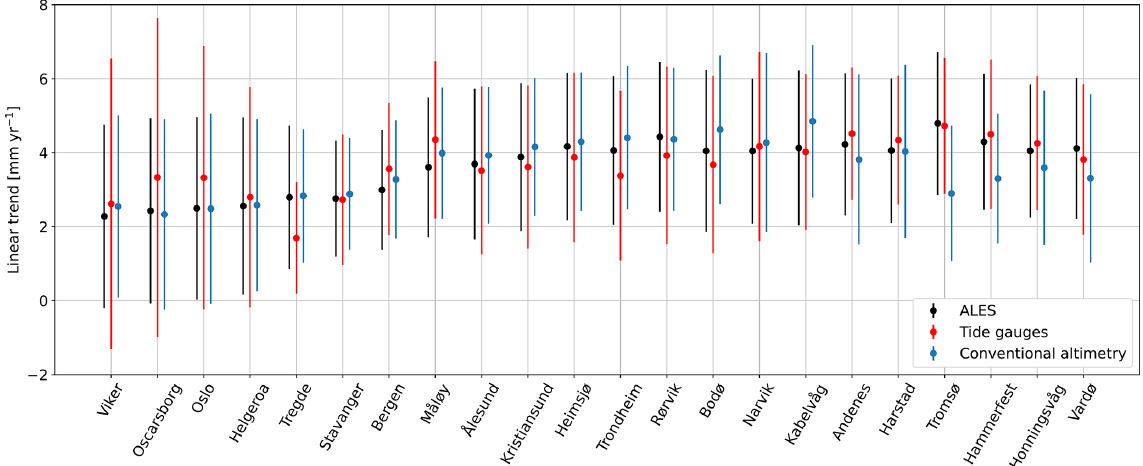
Figure C5. At each tide-gauge location, the linear trend of the SLA from the ALES-reprocessed altimetry dataset (black dots), the conven- tional altimetry dataset (cyan dots), and tide gauges (red dots). The error bars show the 95th confidence intervals of the sea-level trend at each tide-gauge